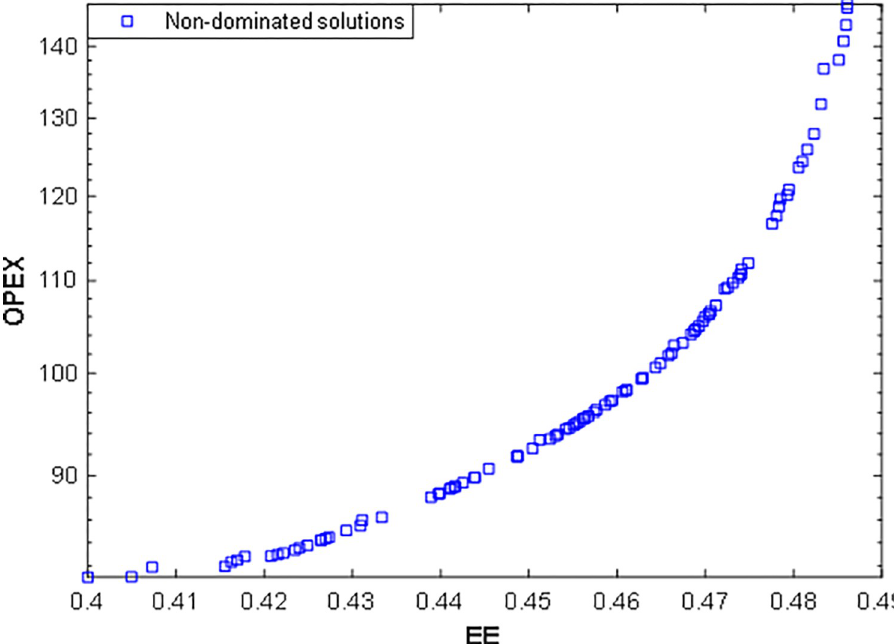
Fig 7. Pareto optimal solutions of the second scenario using HMOGWO.